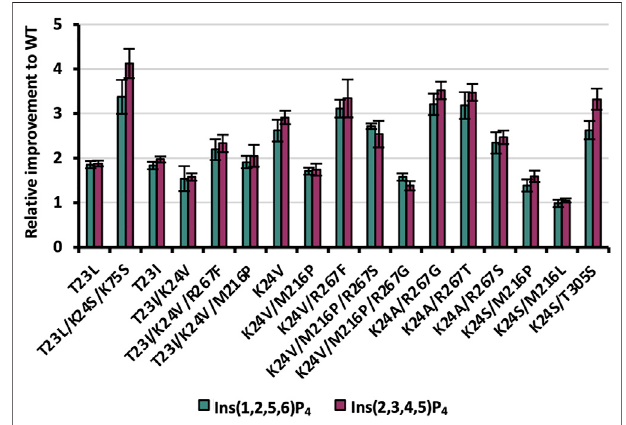
FIGURE 7 | Relative improvements of expressible variants selected during KnowVolution phase III (rationally and based on machine learning predictions). Protein concentrations were adjusted for hydrolysis reactions.